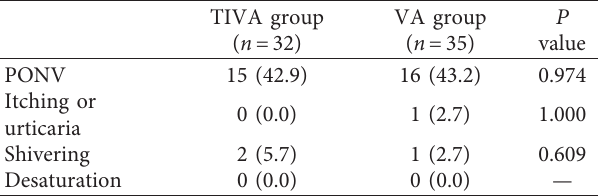
Table 3: Occurrence of postoperative